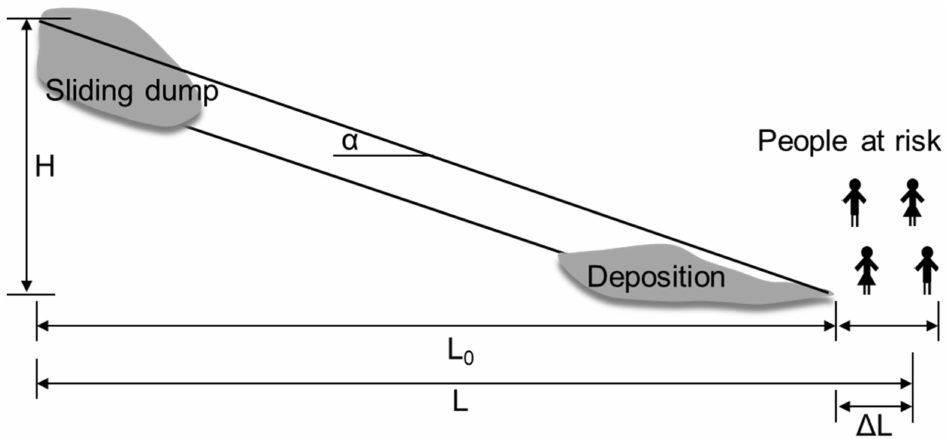
Figure 14. Run-out distance of landfill waste flow.